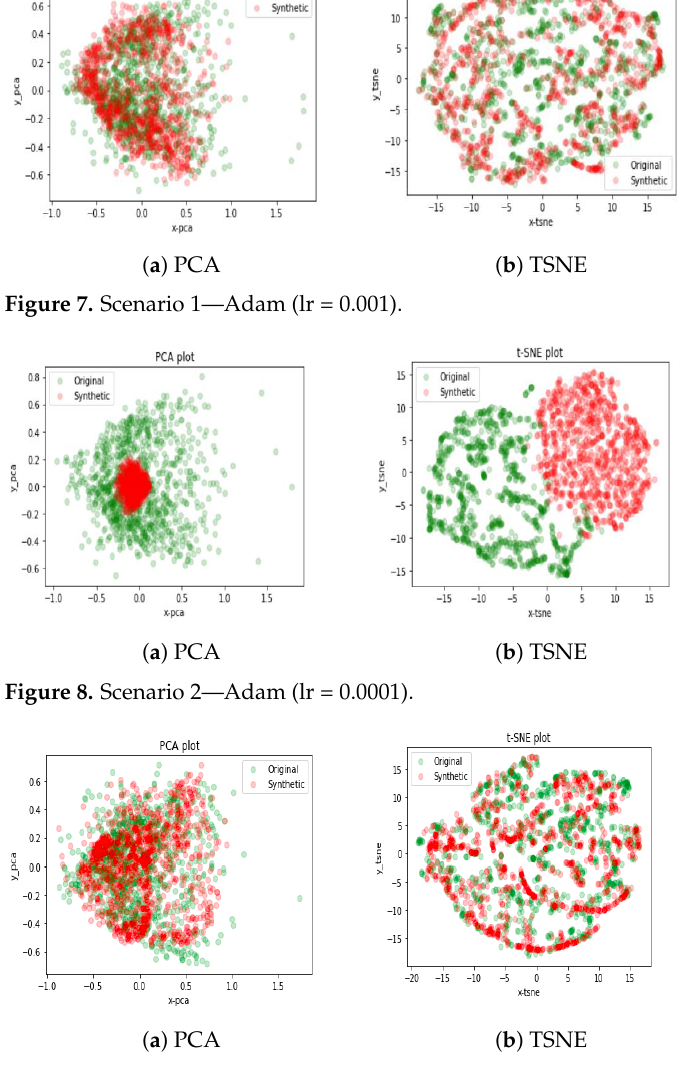
Figure 9. Scenario 3—Adam (lr =